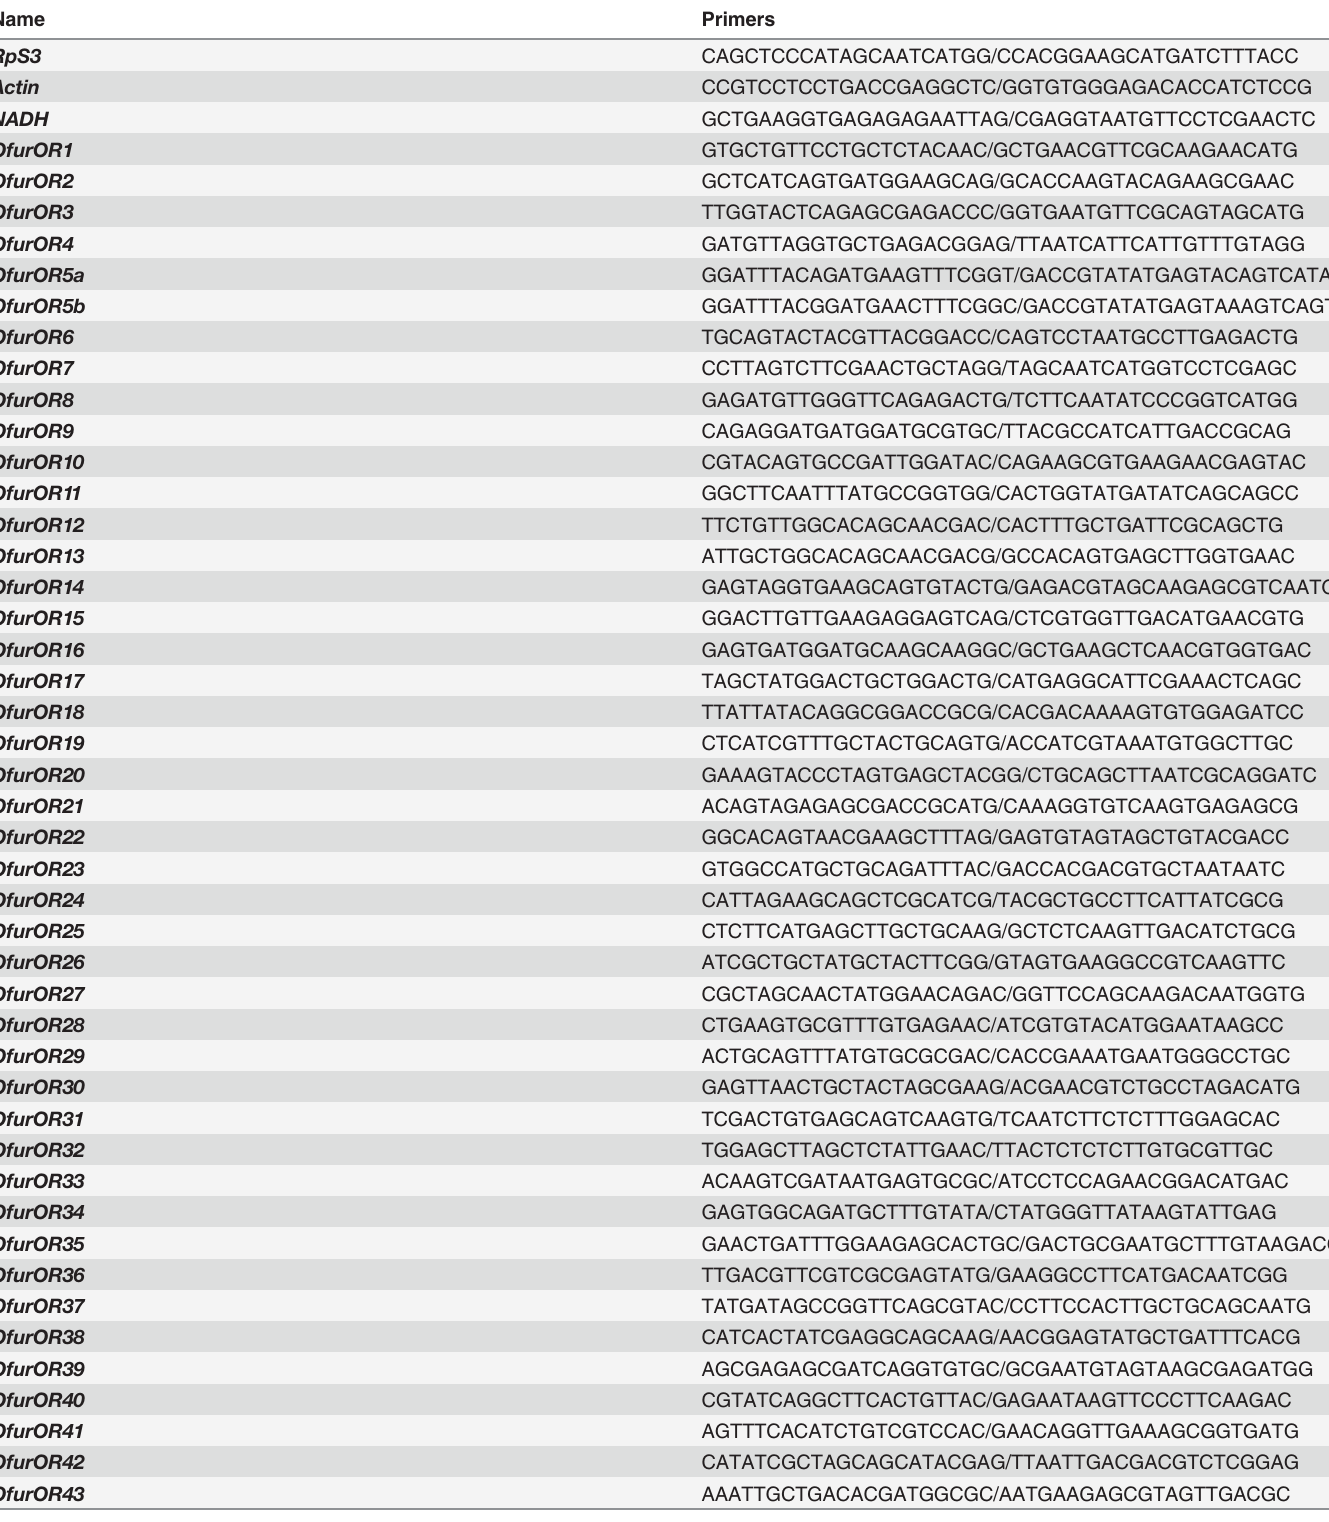
Table 2. Primers used in